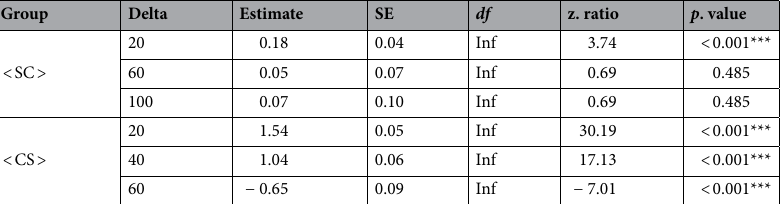
Table 4. Pairwise comparisons of EMMs for each Delta level. Post-hoc comparisons on the Ordinal position of the longer stimulus, within each Group and each Delta level, revealed that for the <SC> group the only statistically significant comparison was at the (cid:31) 20, whereas for the <CS> group all pairwise comparisons were statistically significant. (*** p -value <